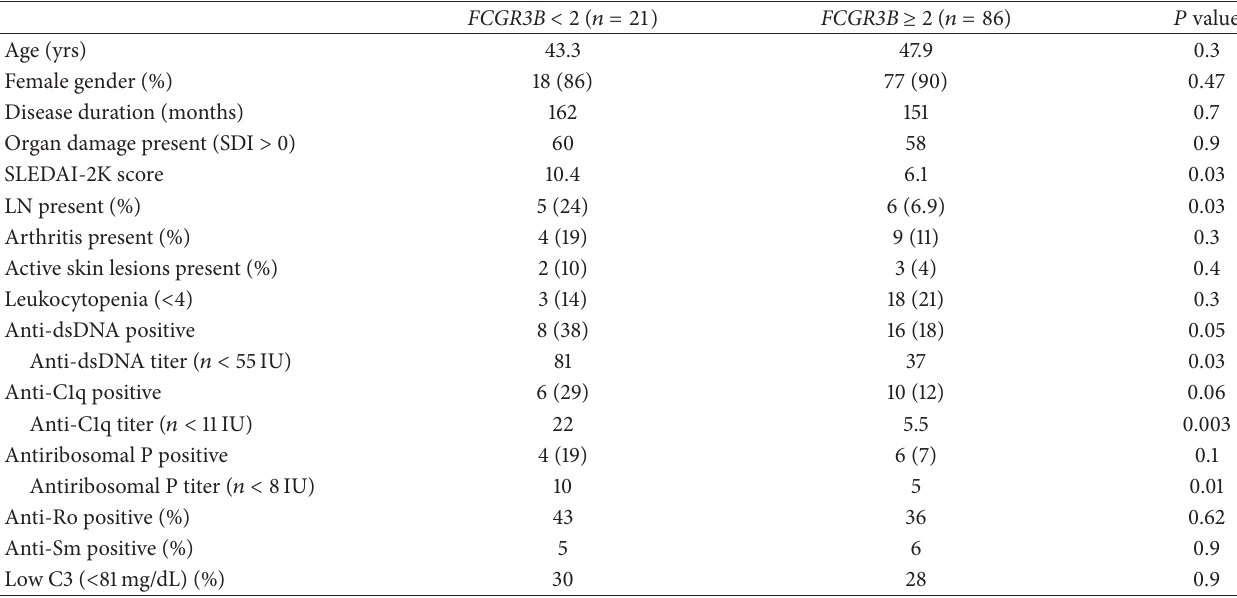
Table 2: Univariate analysis comparing clinical features between SLE patients with low ( < 2) FCGR3B and ≥ 2 FCGR3B gene copy number. Figures indicate mean values or number of patients (percentage). 𝑃 values derive from Mann-Whitney U test and chi-square testing as appropriate.